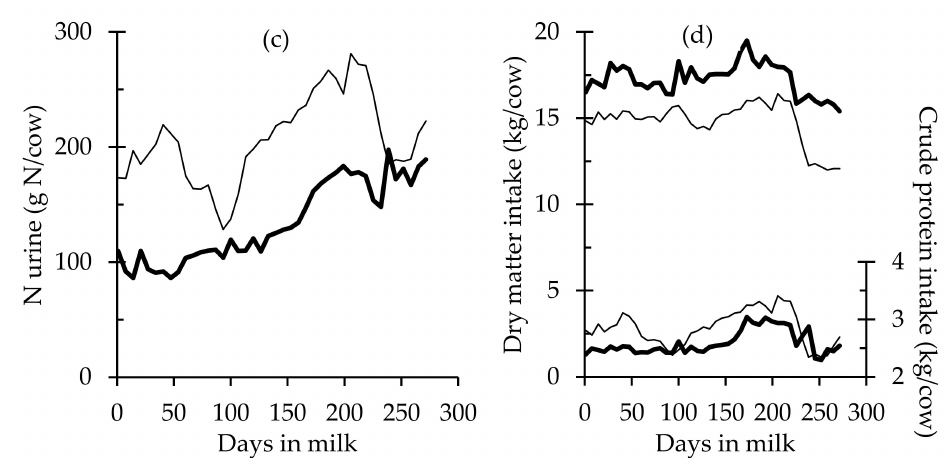
Figure 3. Estimations of ( a ) total nitrogen (N) excreta per cow (g N / day) and partitioned into ( b ) urine (g N urine / day) and ( c ) faeces (g N faeces / day), along with ( d ) dry matter intake (DMI) per cow (kg DMI / day) and crude protein intake (CPI) per cow (kg CPI / day), in two grazing dairy systems: